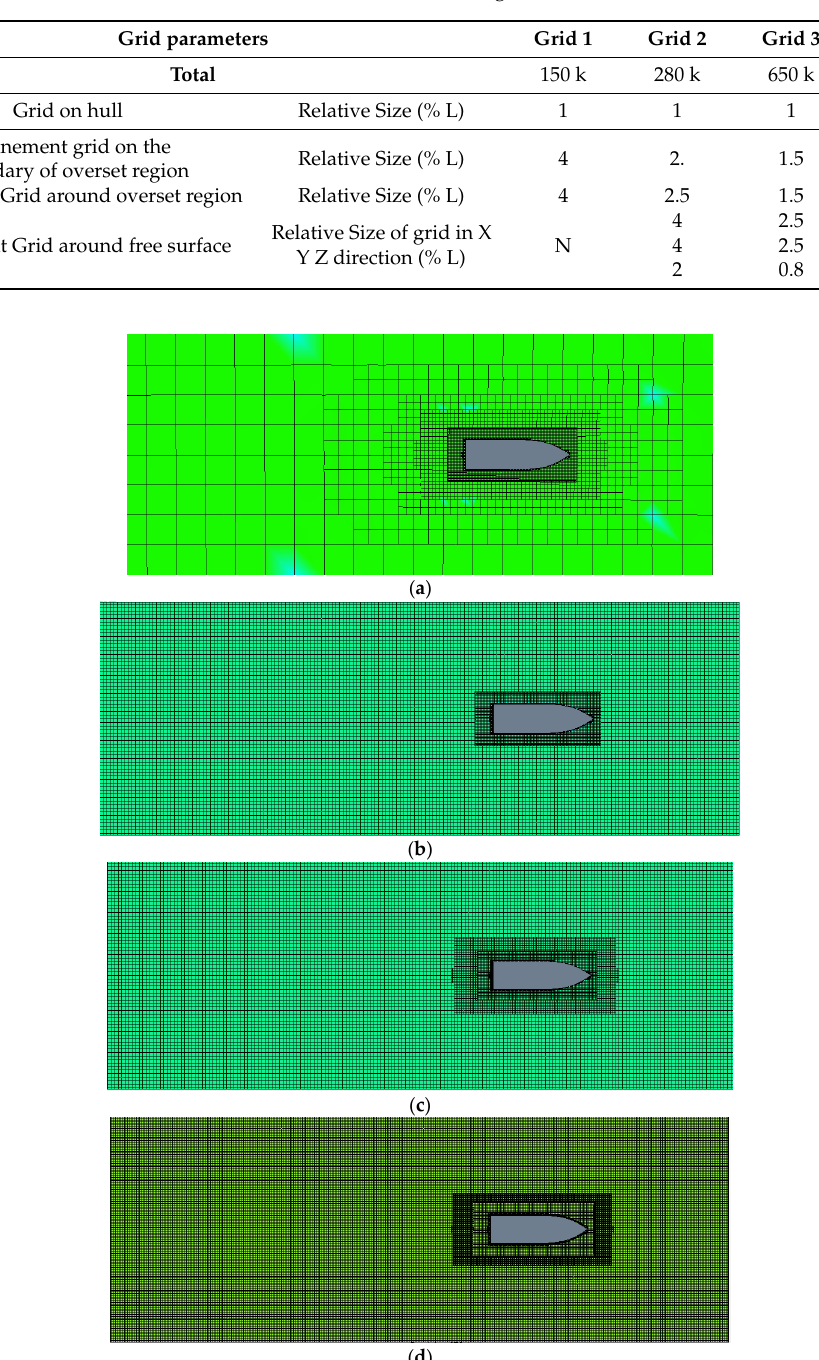
Figure 8. Grids of the free surface: ( a ) Grid 1, ( b ) Grid 2, ( c ) Grid 3, ( d ) Grid 4. The numerical results of the four grids are presented in Table 5, the resistance curves are presented in Figure